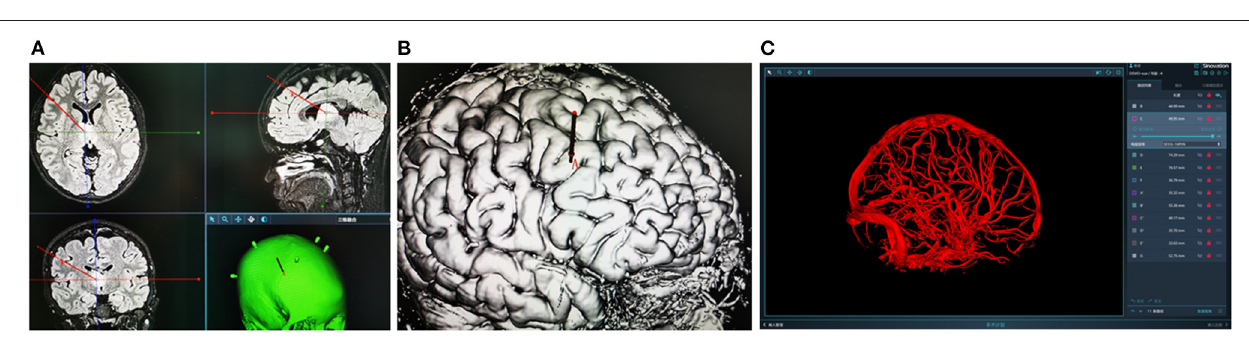
margin < 0.35 mm. After skin asepsis and placement of surgical drapes, the robotic arm was positioned in line with the